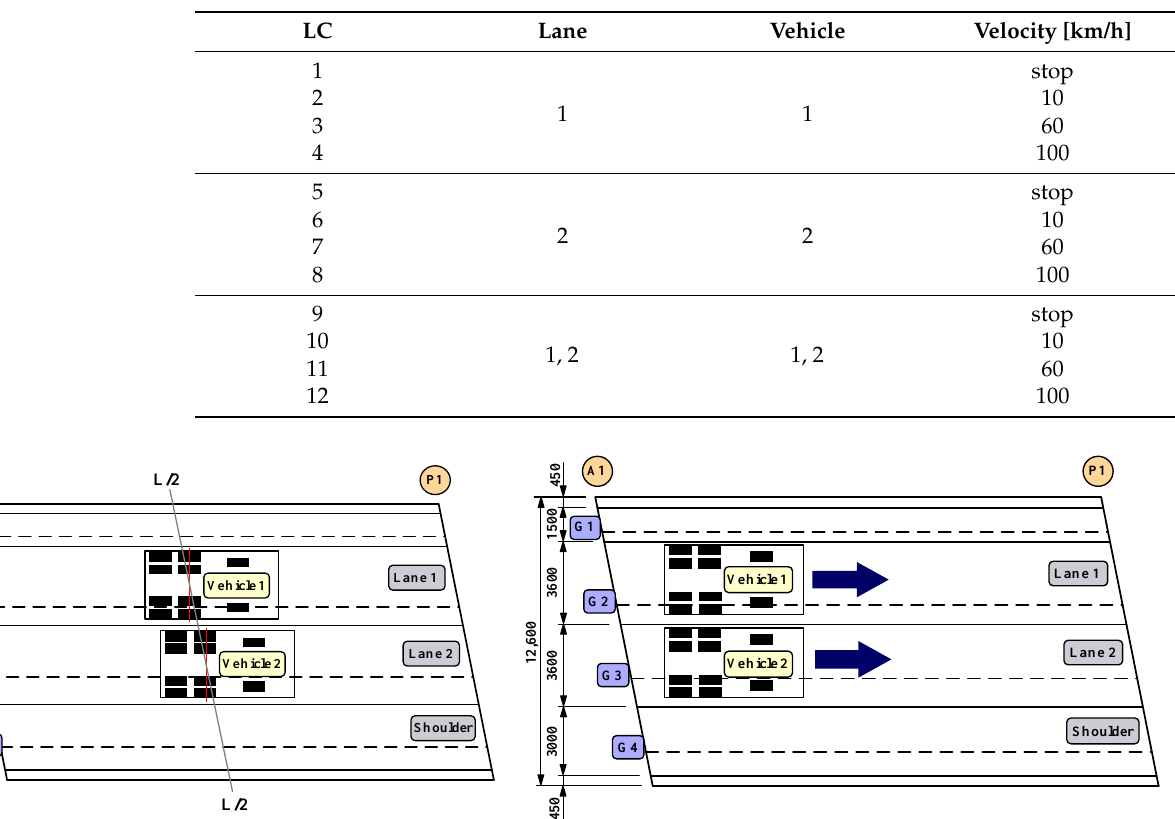
Table 2. LC of the vehicle loading test.